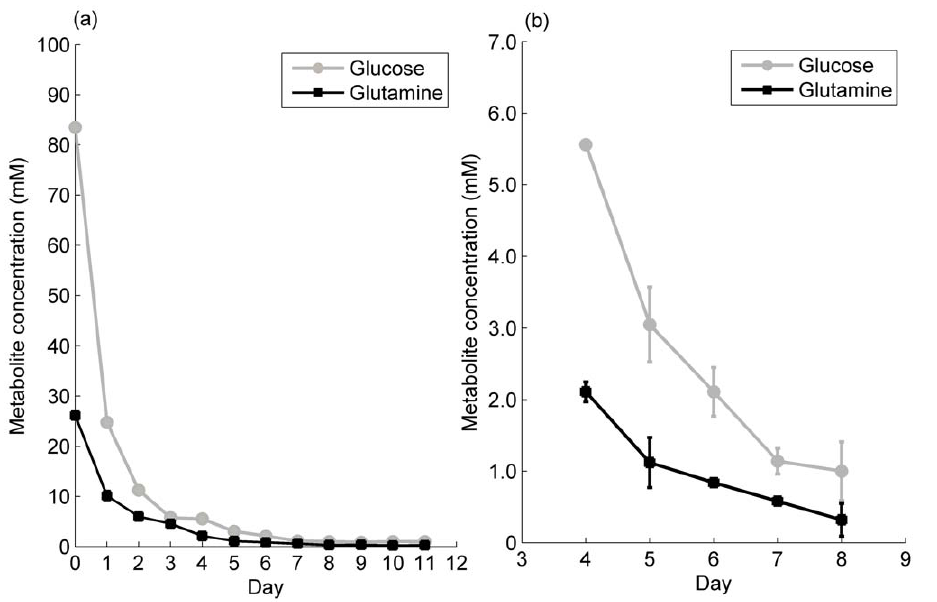
Figure 1. Intracellular metabolite concentration ranges during batch overgrow CHO-S culture. a) Glucose concentration measured by the Amplex Red H glucose oxidase assay (gray circles) and glutamine concentration measured by a coupled glutaminase, glutamate dehydrogenase assay with correction for glutamate concentration (black squares) over the course of the batch overgrow culture. Error bars represent one standard deviation of the mean (n=4 flasks with three enzymatic assay samples per flask) b) A closer view of the concentration of metabolites on days 4 to 8 (exponential to early stationary phase). doi:10.1371/journal.pone.0034512.g001 the linear range of concentration measurement appears to be reported. Since the relationship remained linear, had the same preserved. However, for the glutamine biosensor, the absolute midpoint, and appears to be directly downshifted from the values values of our FRET ratios were consistently lower than those reported by Yang et al, this suggests a systematic difference arising